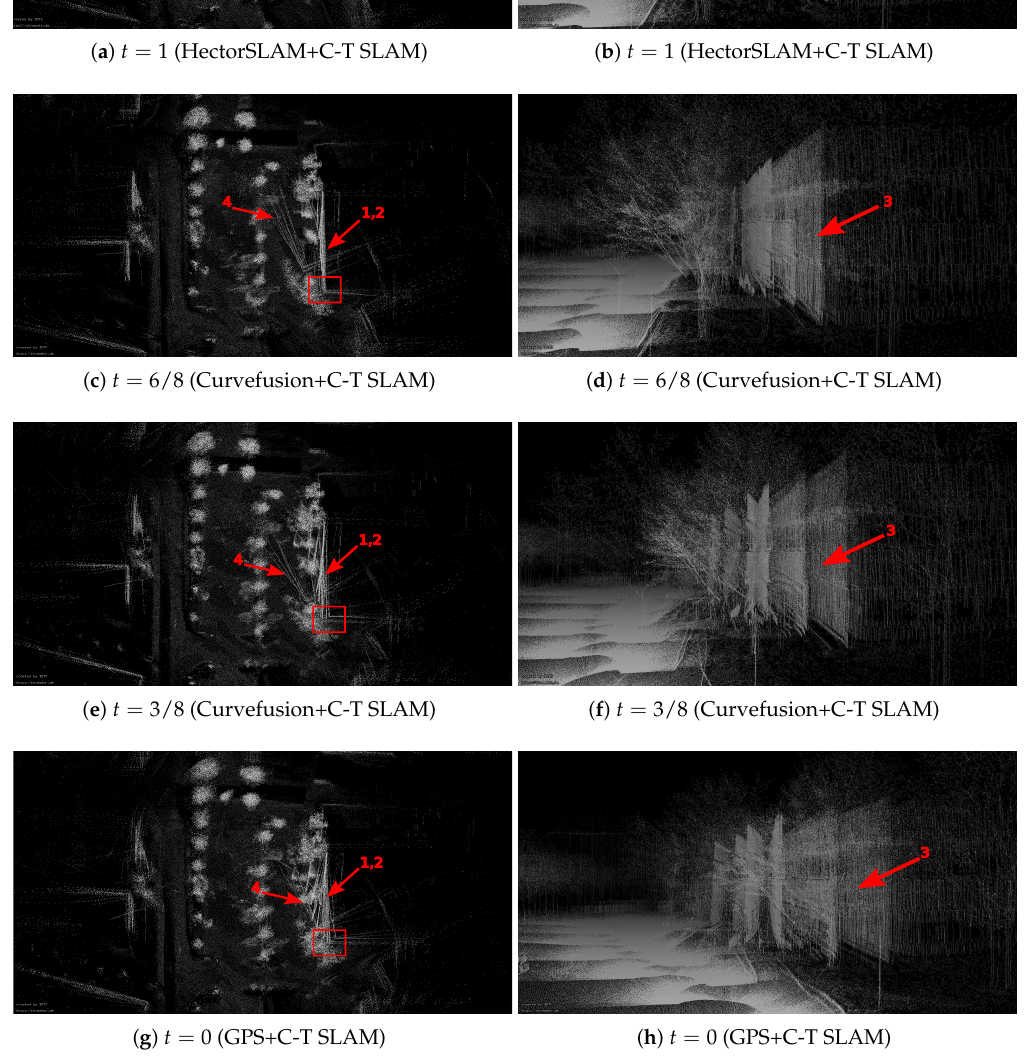
Figure 9. The results are optimized by continuous-time SLAM, and only four trajectories are